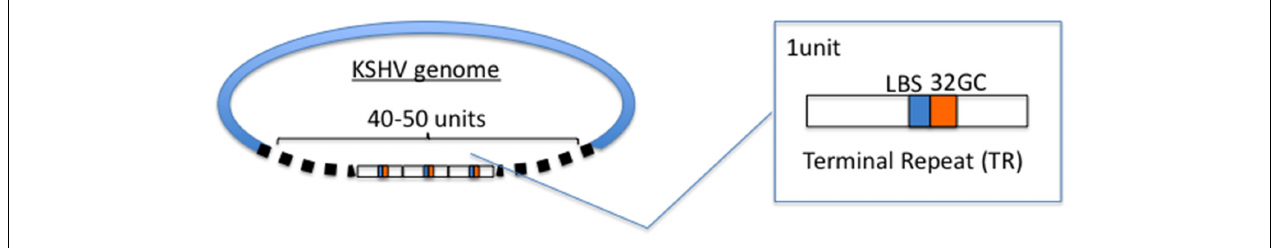
FIGURE 1 |Terminal repeat (TR) sequences. The KSHV genome has 40–50 units ofTR sequences.TR contains LANA-binding site (LBS) and GC-rich sequences termed 32GC. It is thought that one of the LBS-32GC sequence is selected as DNA replication origin